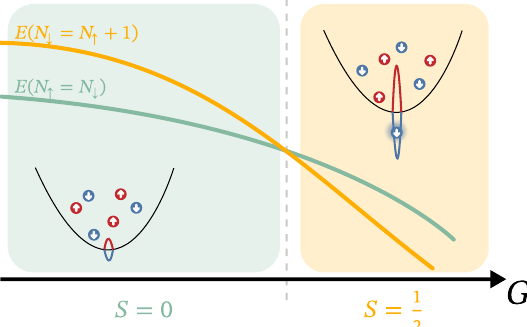
Figure 1: Sketch of the transition driven by the magnetic impurity. With increas- ing the strength of the impurity-fermion interaction, G , a level crossing between the sectors of different fermionic parity (i.e., odd vs. even particle number) occurs. At the same time, the magnetization of the ground state changes from S = 0 to S = 1 The feature persists even in the presence of only a handful of particles and constitutes a precursor of a many-body